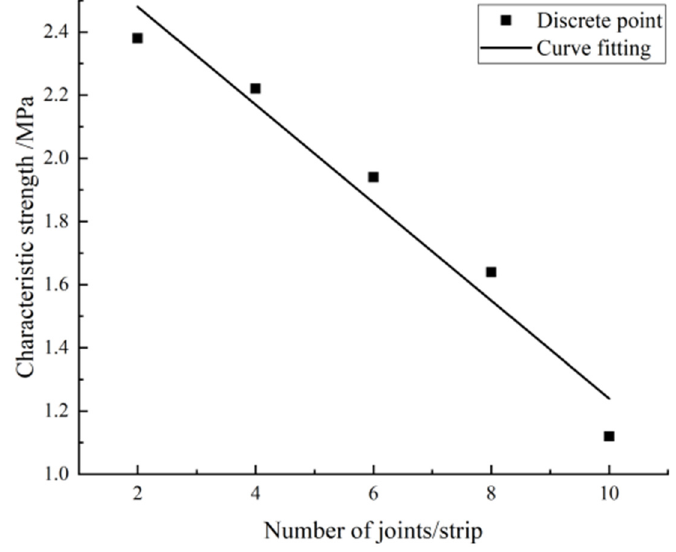
Figure 14. Fitting curve between the characteristic strength and NPJ.